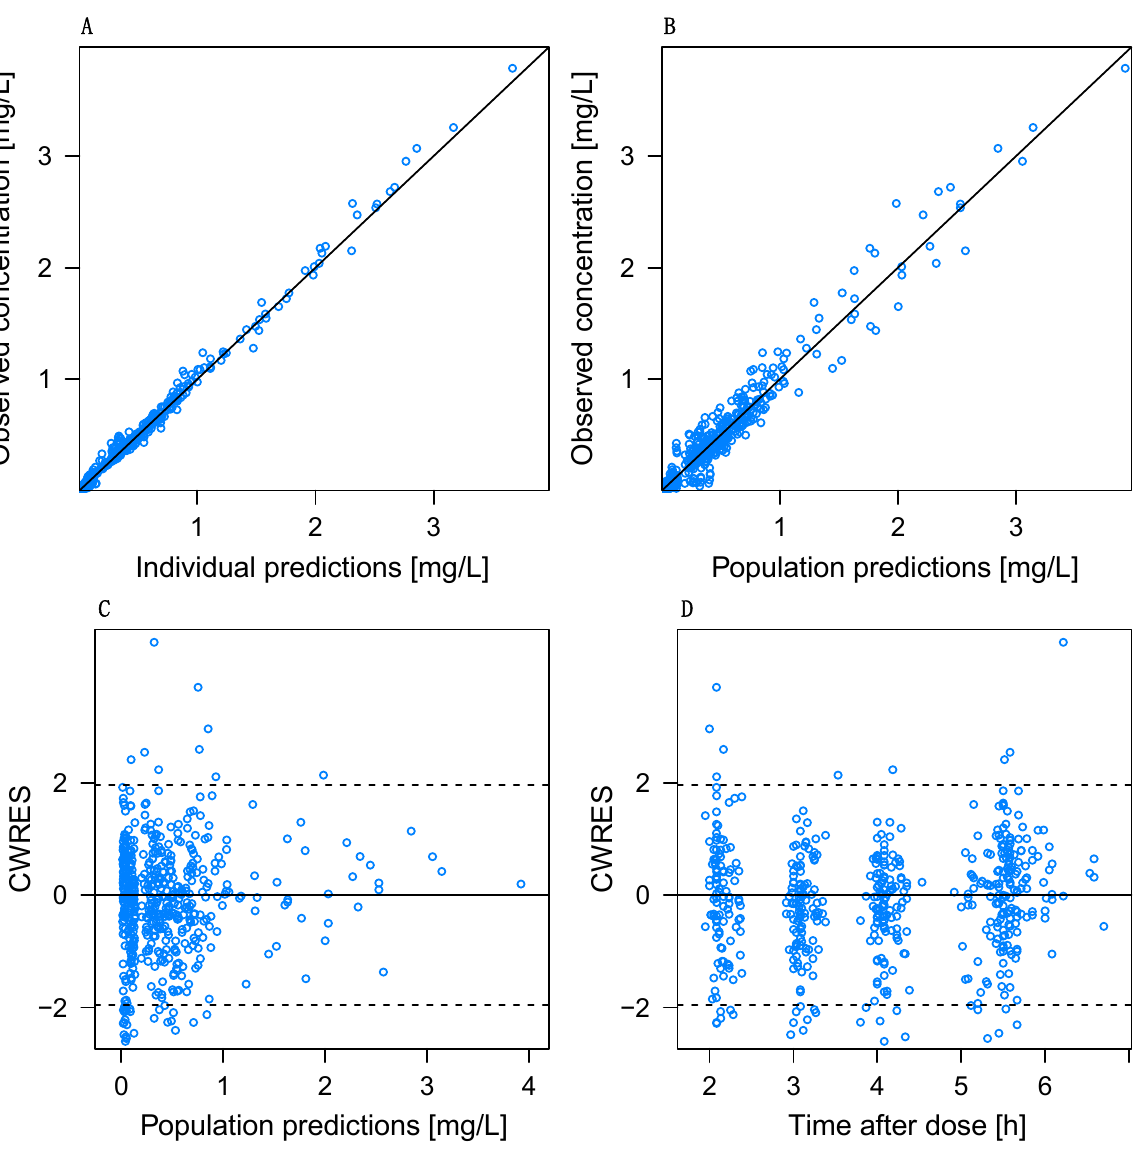
Figure 2. Goodness-of-fit (GOF) plots of the final PK model for busulfan and sulfolane. Observed concentration versus ( A ) individual predicted concentrations, and ( B ) population predicted concen- trations; solid line = line of identity. Conditional weighted residuals (CWRES) versus population predicted concentration ( C ) and time after first dose ( D ).